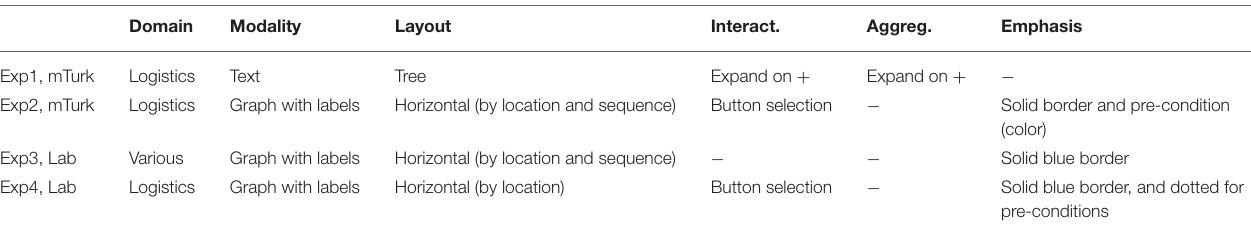
TABLE 1 | The domains, and presentational choices, applied in the experiments. Domain Modality Layout